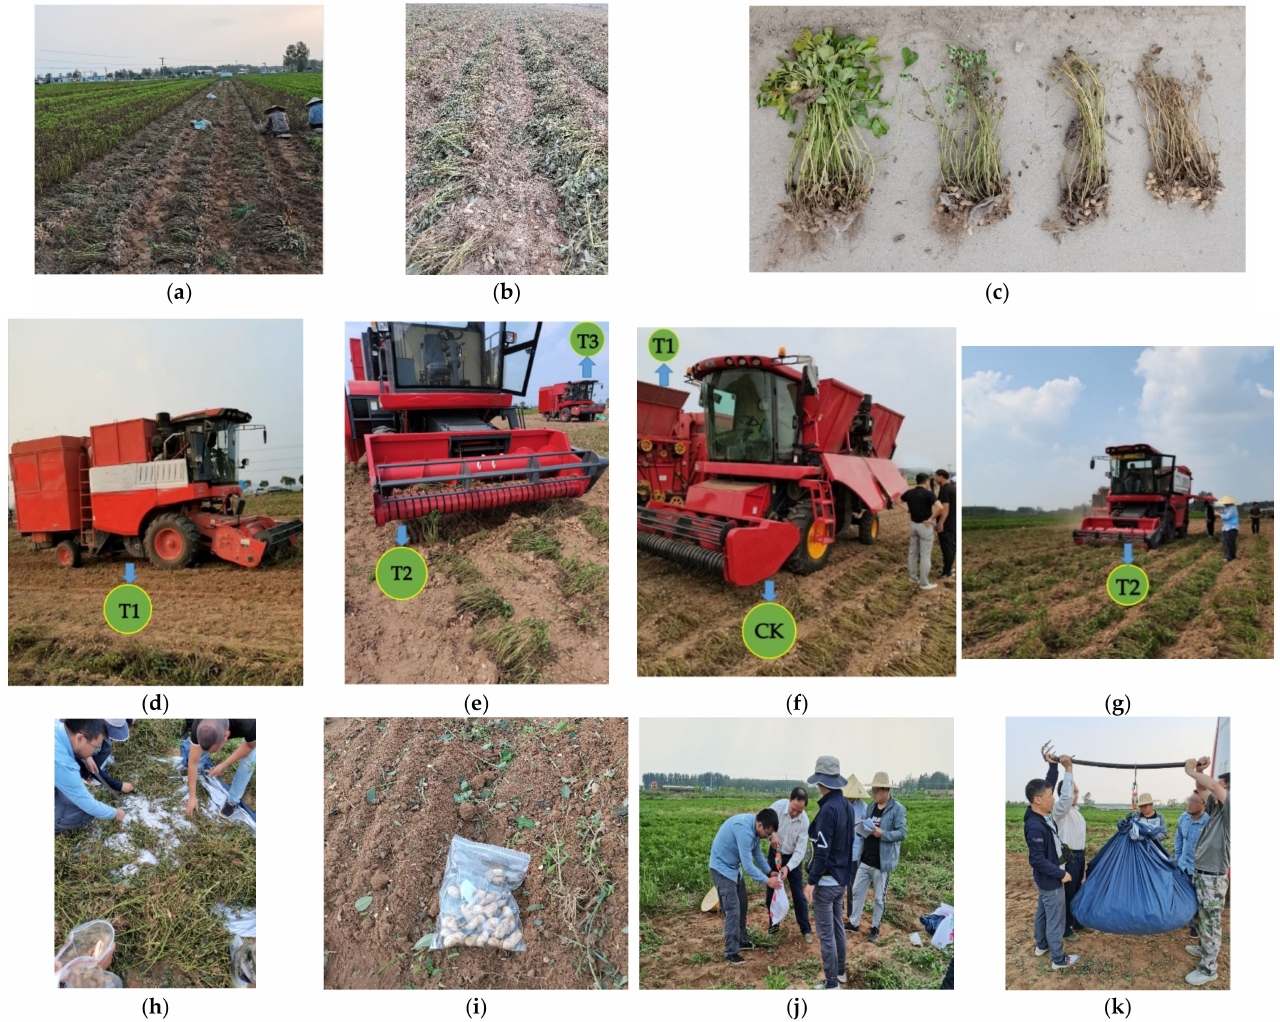
Figure 7. Test scene. ( a ) Before pod-pickup test, dig peanuts manually and lay them neatly; ( b ) peanut plants were drying in the air; ( c ) comparison of plants with variable water content; ( d ) test scene of T1; ( e ) test scene of T2 and T3; ( f ) test scene of CK; ( g ) test scene of T2; ( h ) selecting missed peanut pods (to measure the missing-pickup rate); ( i ) missed peanut pods; ( j ) weighing crushed peanut pods (to measure the pod crushed rate); ( k ) weighing peanut seedlings (to measure the missing-pickup rate and the pod crushed